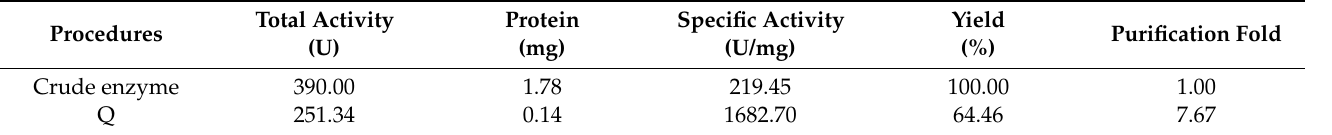
Figure 1. The α -galactosidase activity of various mutagenic strains (C18: Initial strain; UV-5: Ultra- violet mutagenic strain; D-23: Chemical mutagenic strain).